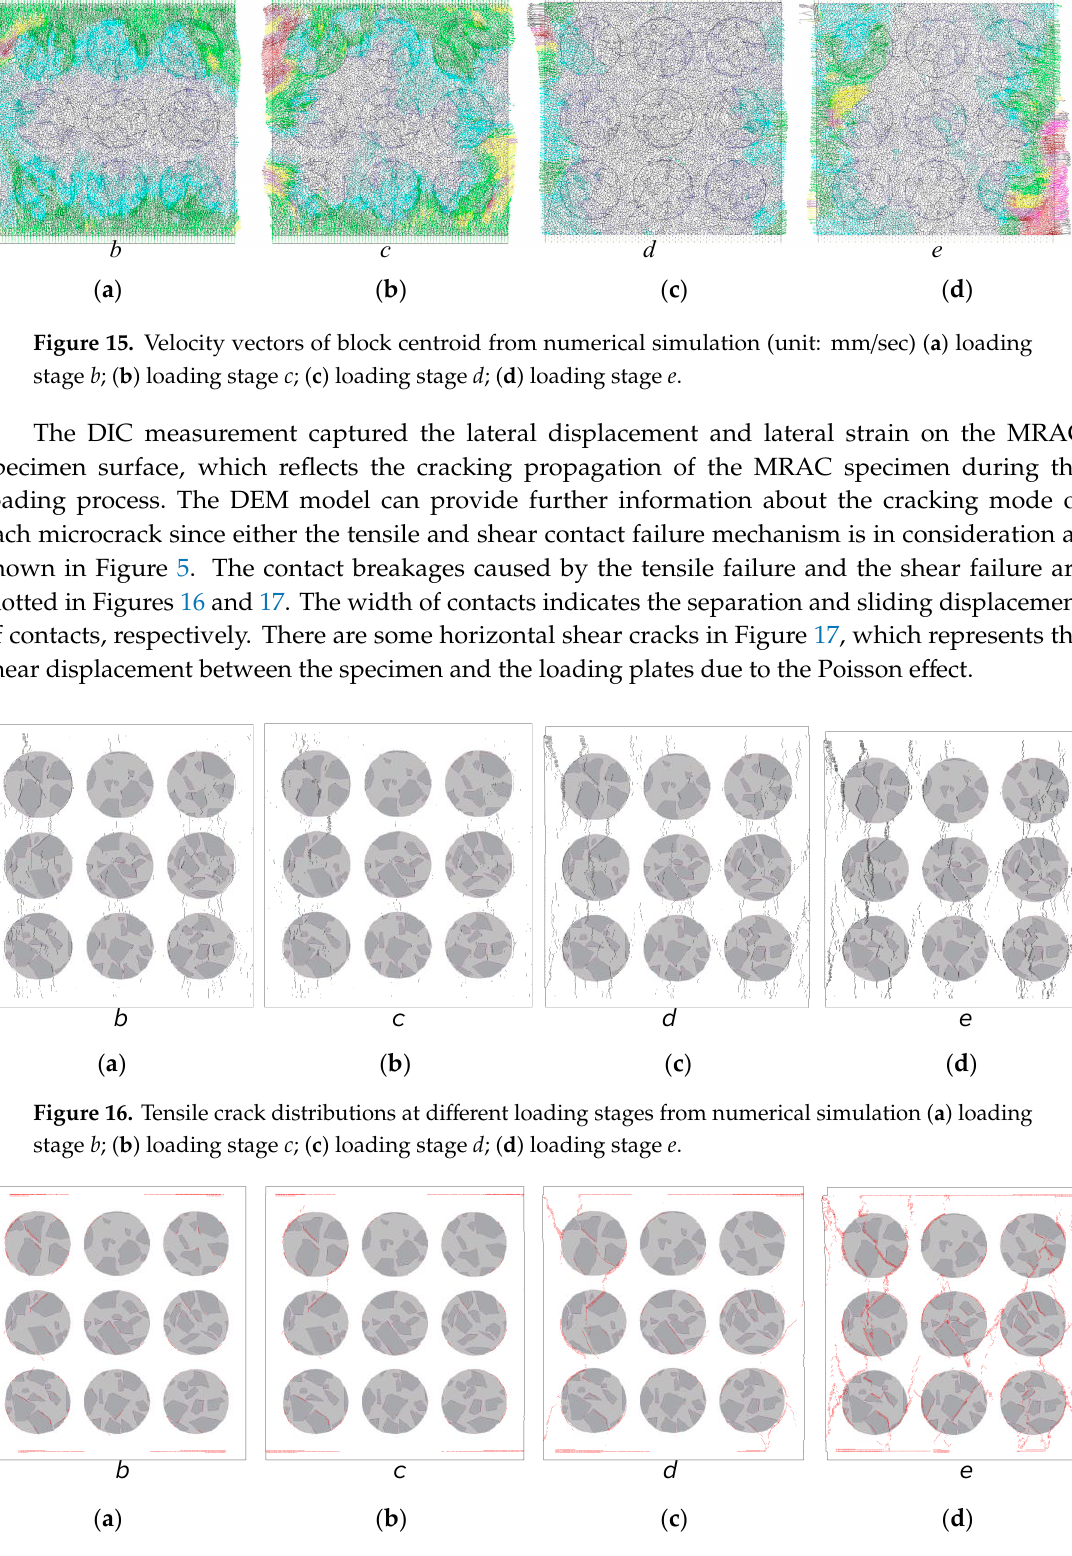
Figure 14. Lateral strain distribution contour maps from DIC measurements ( a ) loading stage b ; ( b ) loading stage c ; ( c ) loading stage d ; ( d ) loading stage e .